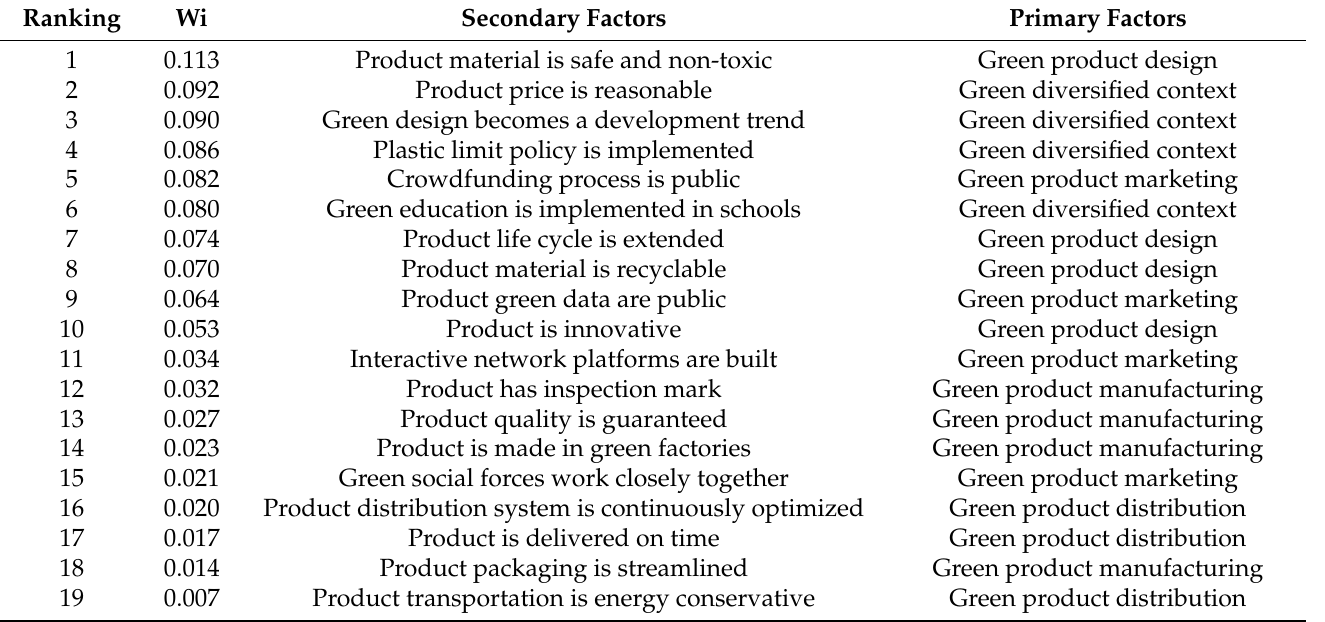
Table 13. Priority ranking of all